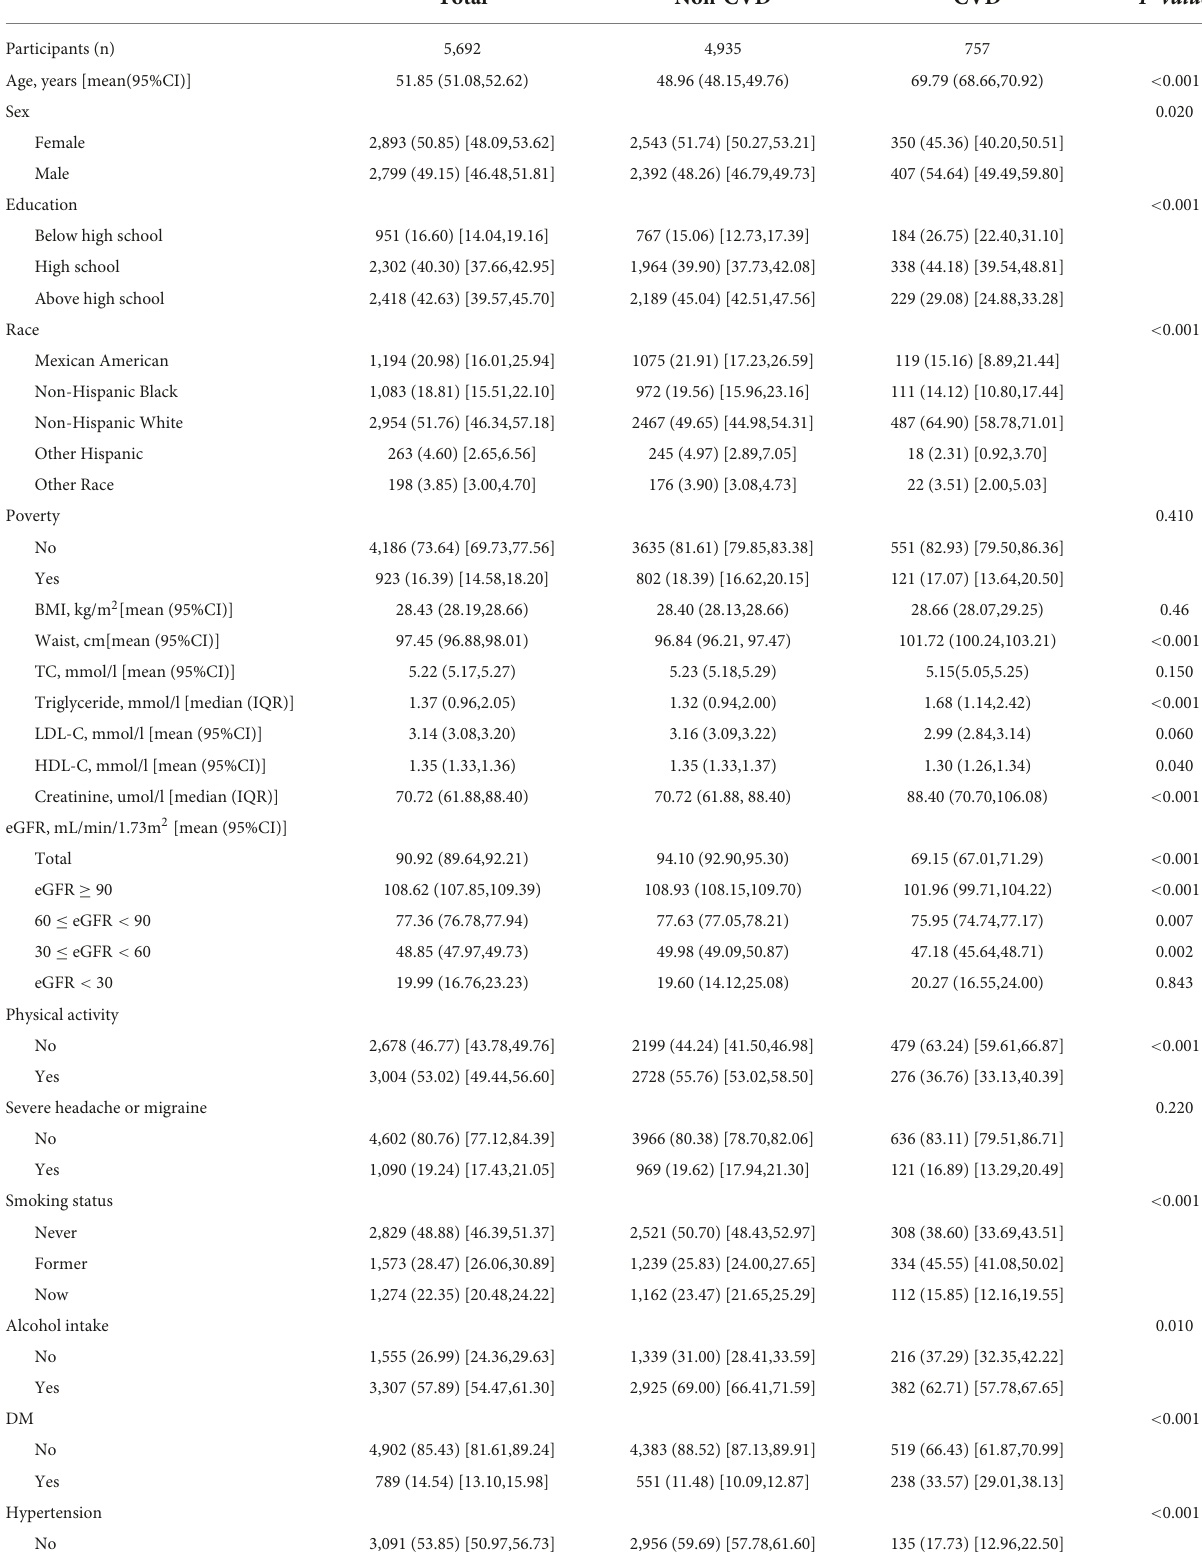
TABLE 1 Baseline characteristics of the study participants